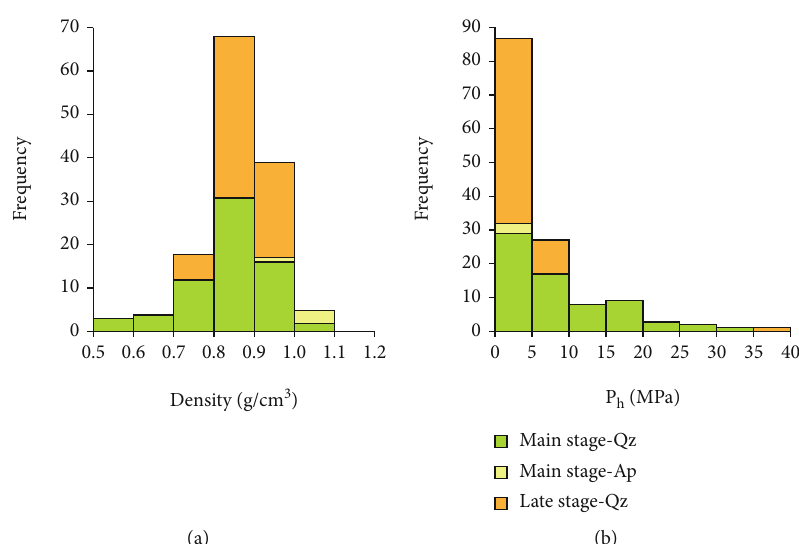
Figure 14: Histograms of densities (a) and pressure (b) of fl uid inclusions in the main ore stage and the late stage. Ap: apatite; Qz: quartz.